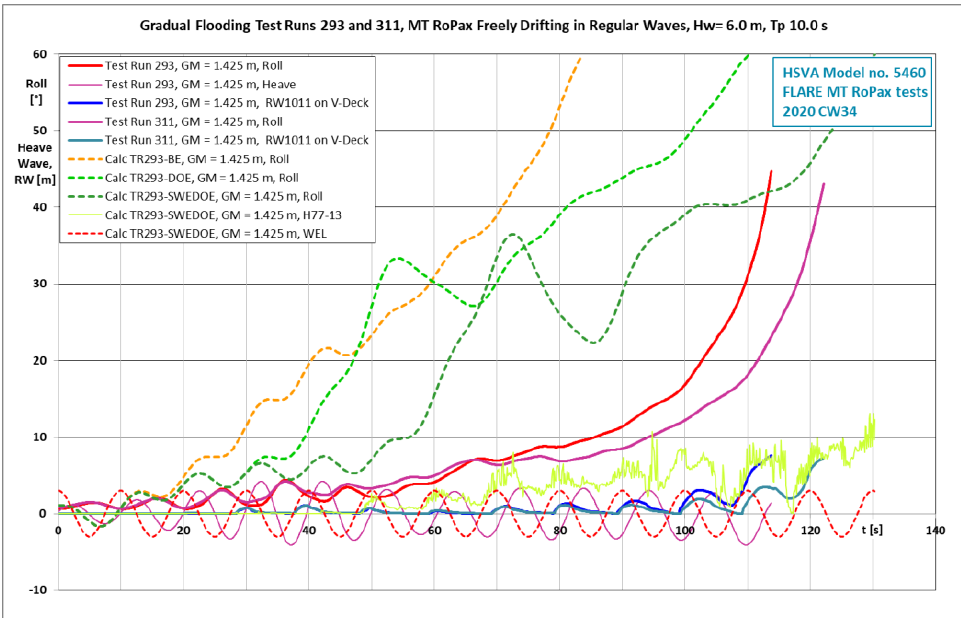
Figure 8. Computed and experimental time histories of the roll angle of the ship in regular beam waves with 6.0 m wave height, shown until capsize. The dashed curves at the center show the computed results obtained using the boundary conditions BE, DOE, and SWEDOE.